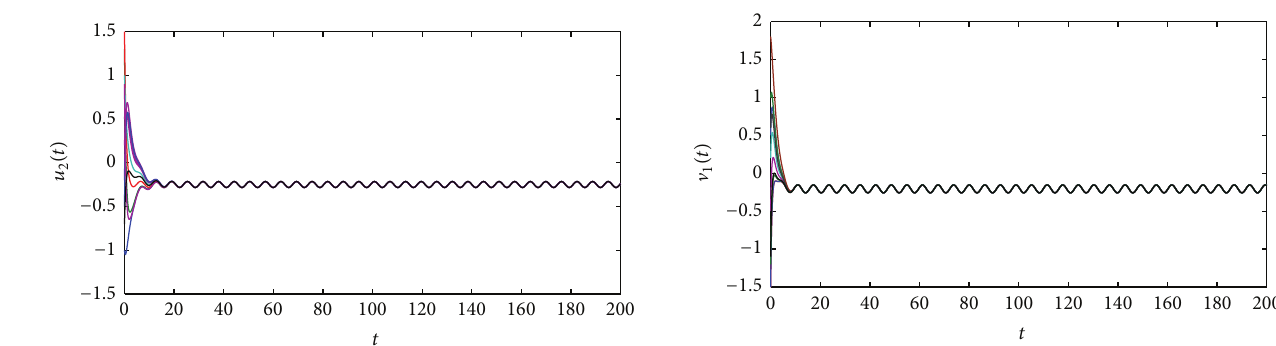
Figure 4: Transient response of state variables V 1 (𝑡) of Example 1.